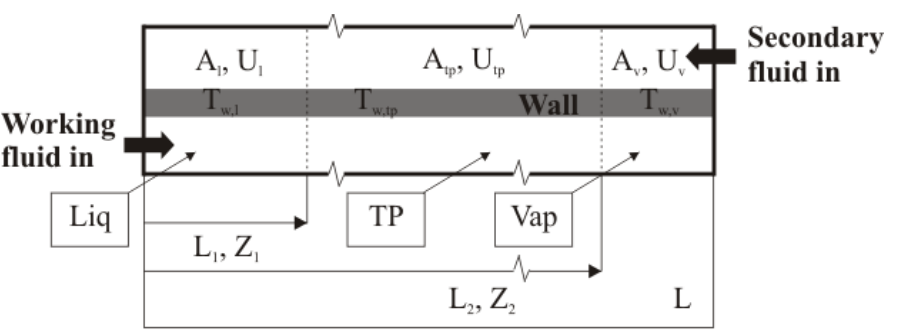
Figure 3. Three-zone heat exchanger model (evaporator).